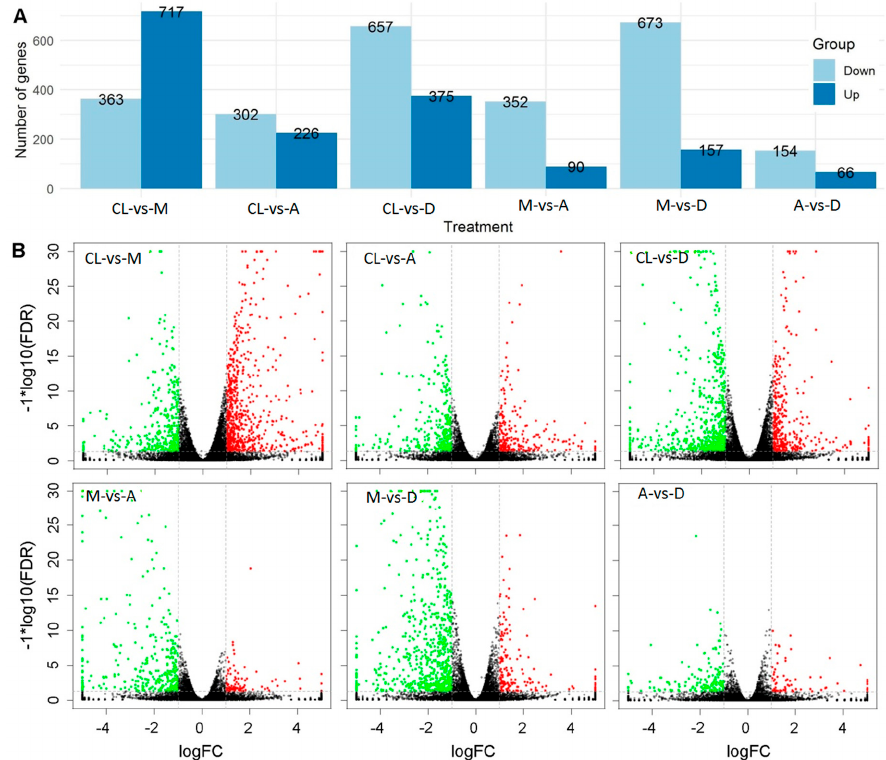
Figure 3. Di ff erence analysis of gene expression between treatments. ( A ) Comparison of the number of up- and down-regulated genes. ( B ) Volcano plots between treatments and control. Red and green points represent up- and down-regulated genes, respectively. Block points represent no difference genes.